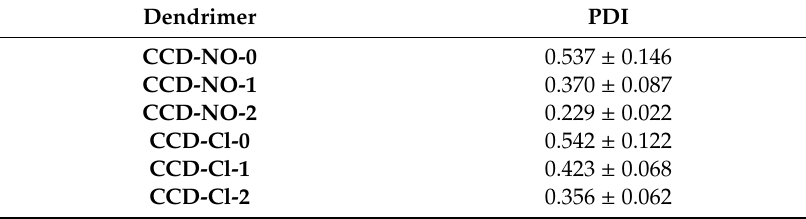
Table 3. Polydispersity index (PDI) of copper metallodendrimers with nitrate and chloride surface